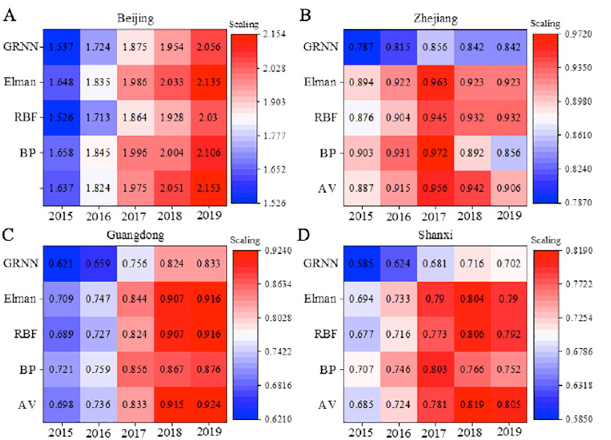
Fig 7. Prediction results of different carbon emission prediction models in different provinces. Republished from “Prediction of Direct Carbon Emissions of Chinese Provinces using Artificial Neural Networks” under a CC